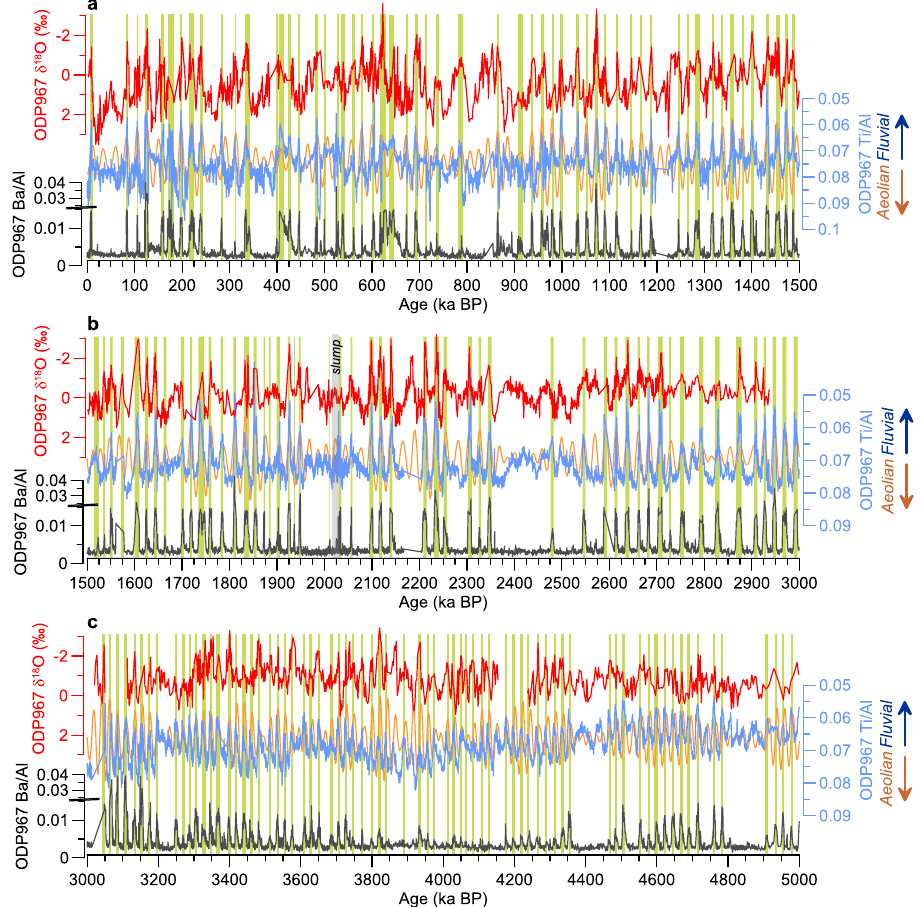
Fig. 3 Green Sahara Periods over the last 5 Myr. ODP Site 967 records of planktic foraminifera ( G. ruber ) δ 18 O (red), Ti/Al (blue), and Ba/Al (grey) for time intervals 0 – 1.5 Myr ago ( a ), 1.5 – 3 Myr ago ( b ) and 3 – 5 Myr ago ( c ), with time in kiloyears before Present. Upward peaks correspond to precession minima (orange) and inferred Green Sahara Periods (green shading). (See Supplementary Fig. S2 for detail over a selected